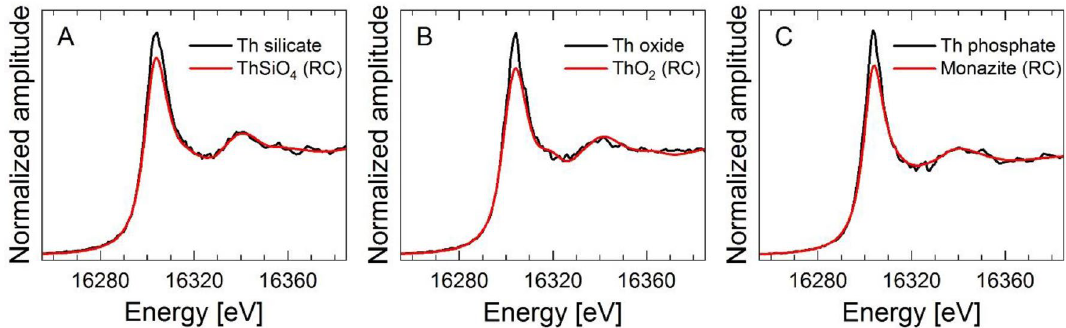
Figure 6. Micro-X-ray Absorption spectra of ( A ) Th-silicate, ( B ) Th-oxide, and ( C ) Th-phosphate rich particles, respectively, with the overlaid XANES spectrum recorded for the ThSiO 4 ( A ), ThO 2 ( B ), and monazite ( C ) reference